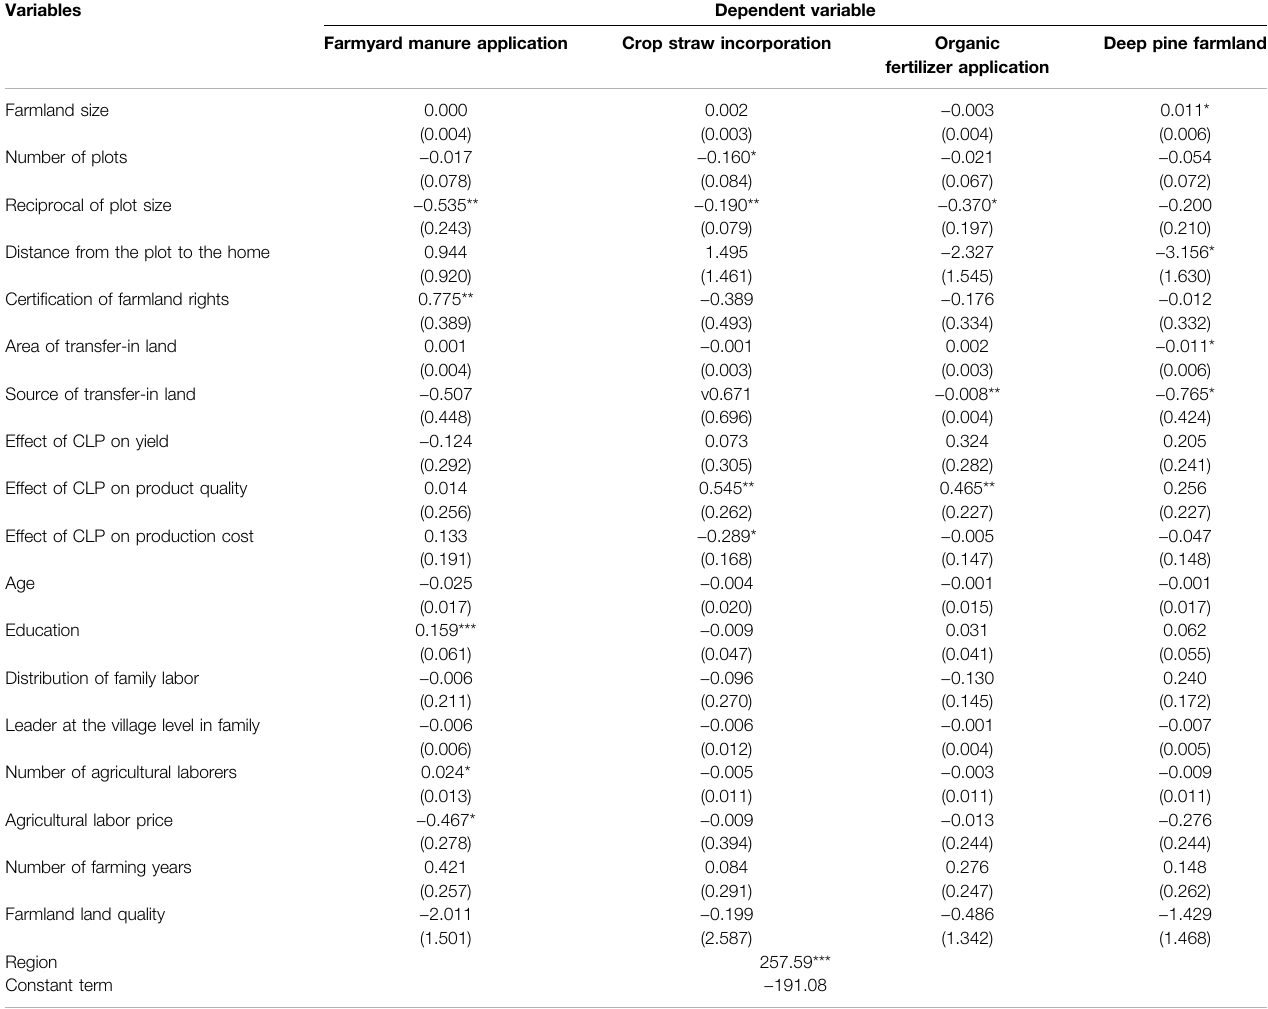
TABLE 5 | Impact of farmland transfer on farmers ’ adoption of CLP techniques. Variables Dependent variable Farmyard manure application Crop straw incorporation